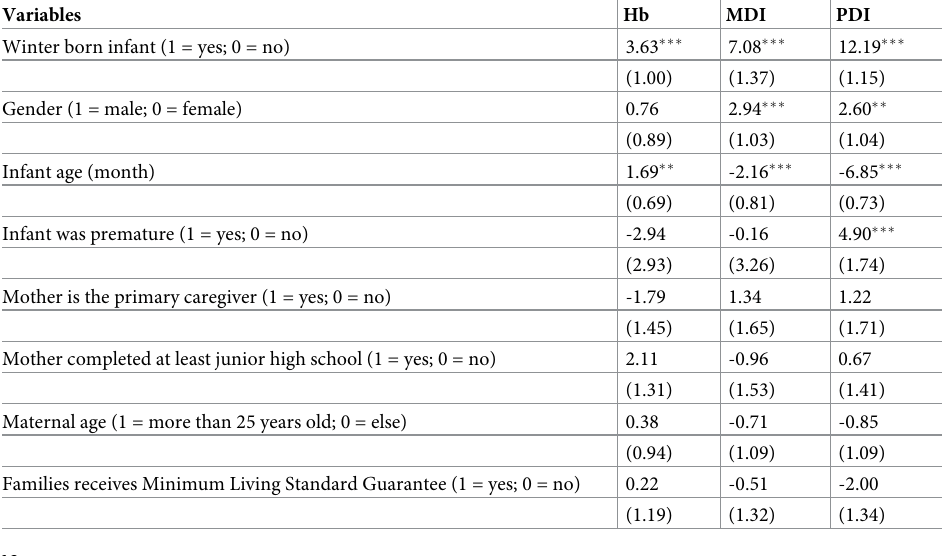
Table 4. Association of season of birth and development outcomes of infants in poor rural Qinba mountainous area ( N = 650). Variables Hb MDI